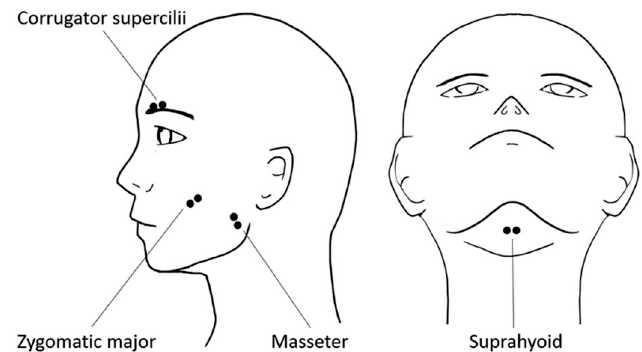
Figure 2. Schematic illustrations of electrode placement for electromyography recording of the corrugator supercilii, zygomatic major, masseter, and suprahyoid muscles.